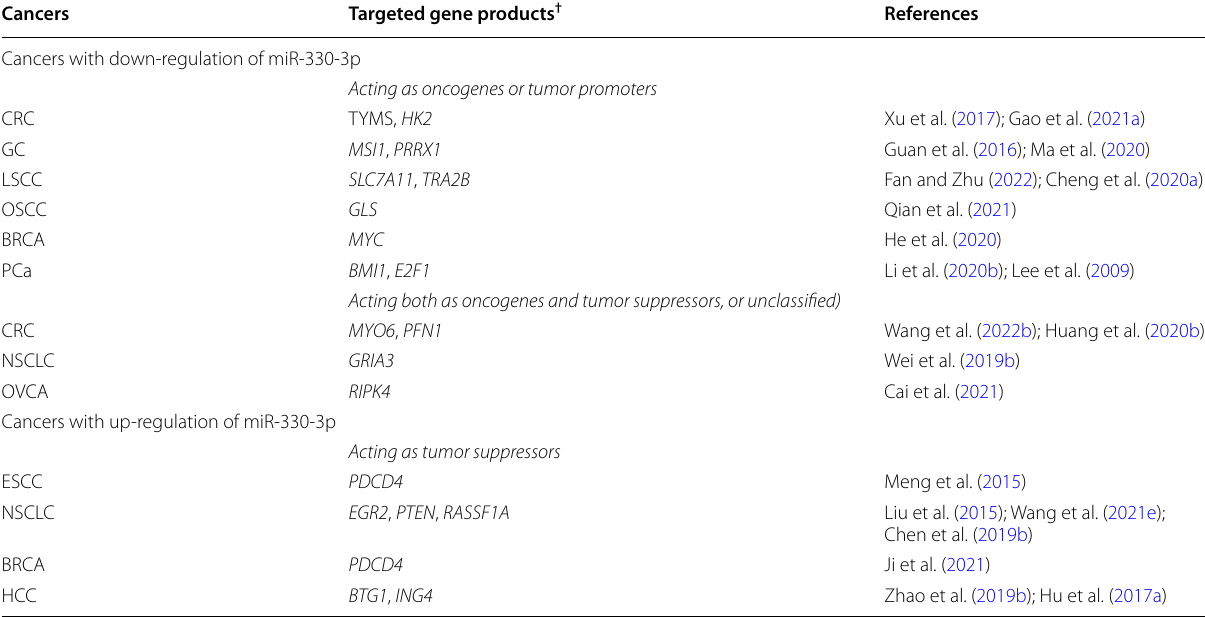
Table 11 Major genes targeted by miR-330-3p in various types of